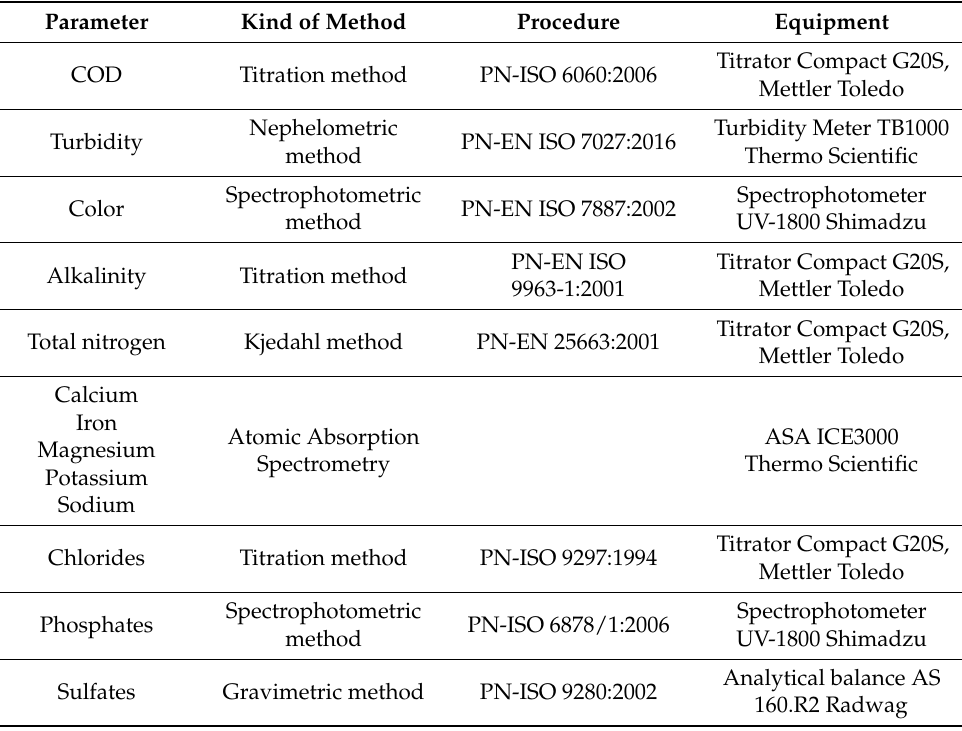
Table 5. The methods for the selected parameters’